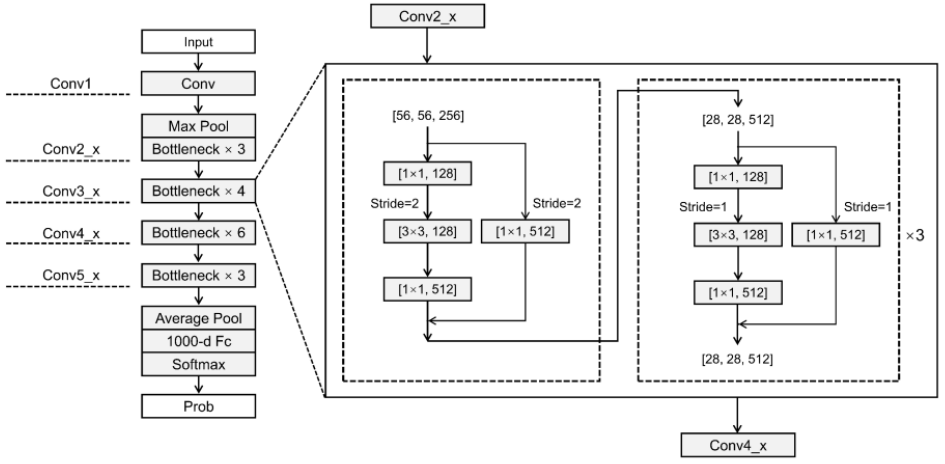
Figure 4. ResNet50 network structure.